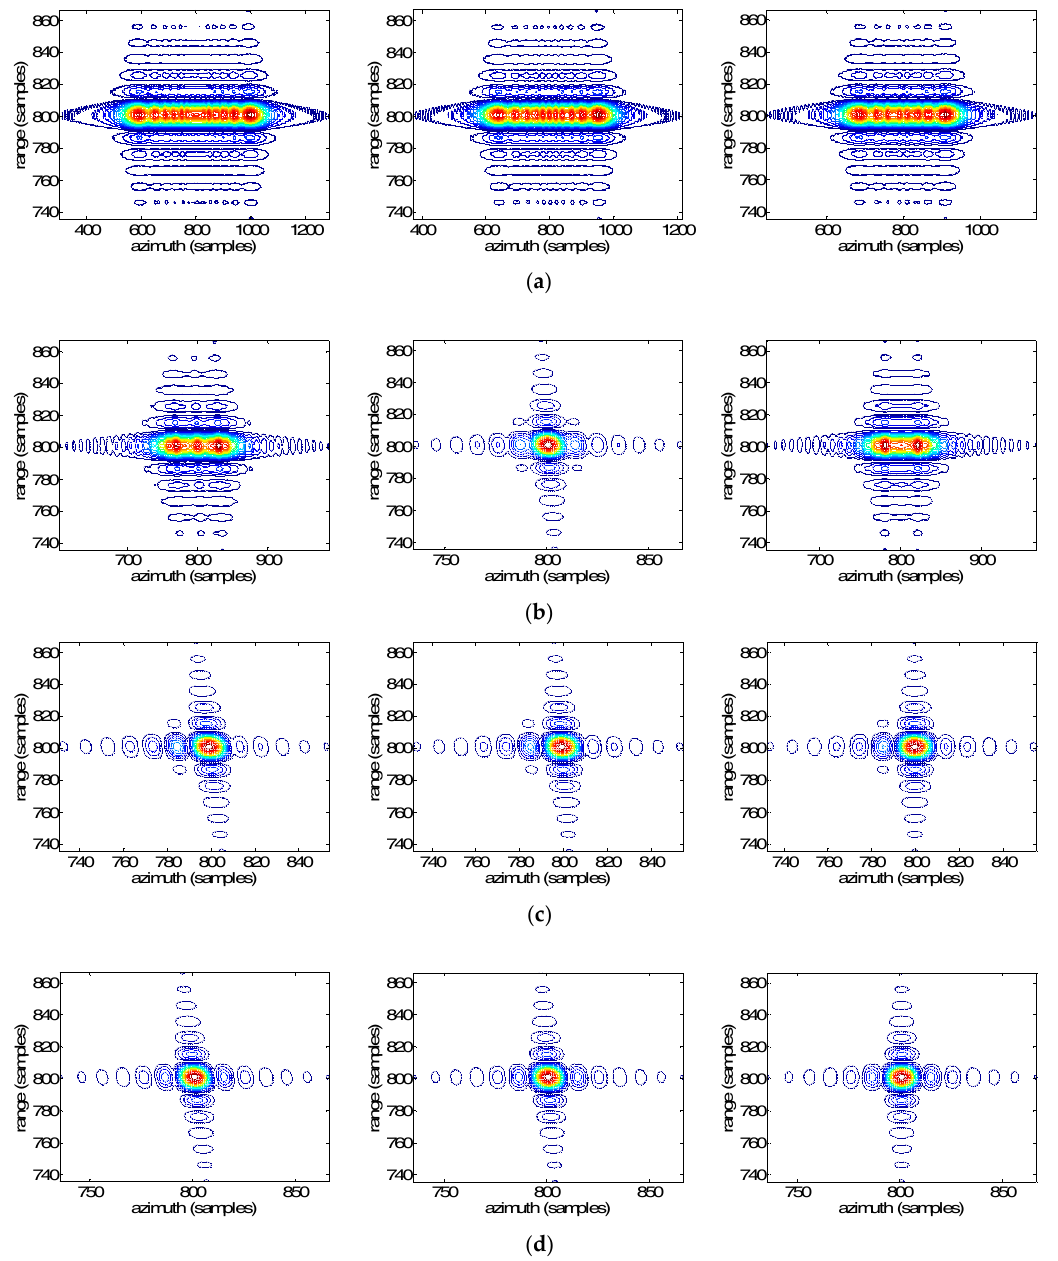
Figure 9. The two-dimensional imaging results of targets by the different methods with the velocity and acceleration errors. ( a ) No Doppler parameter estimation; ( b ) the basic MAM method; ( c ) the IMAM method; ( d ) the EMAM method.